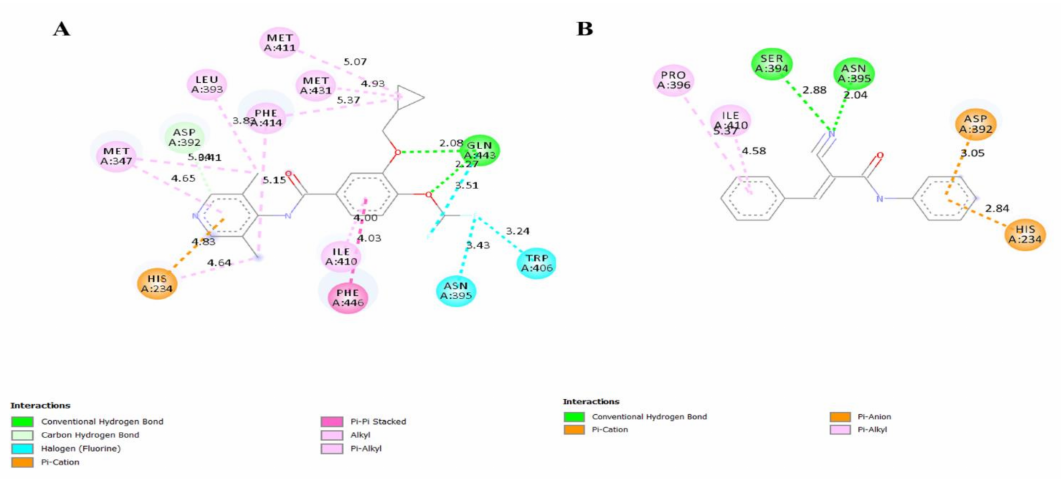
Figure 8. Ligand Roflumilast ( A ) and JMPR-01 ( B ) in PDE4B target (PDB ID: 1XMU). The influence of COX-2 in anti-inflammatory therapy is suggested, which highlights its specific up-regulation at the site of inflammation, mainly in response to the local release of cytokines such as IL-1 and TNF- α , activators of the NF-kB transcription factor [55]. Through the metabolism of arachidonic acid, these generate pro-inflammatory and va- soactive eicosanoids such as prostaglandins (PGD2, PGE2, PGF2 α ), prostacyclins (PGI2), and thromboxanes (TXA2) [56]. Thus, its selective inhibition is an effective way to obtain anti-inflammatory, analgesic, and antipyretic activity without harming the physiological actions inherent to COX-1, a target inhibited by traditional NSAIDs [57]. The selective inhibitor Celecoxib, (IC 50 = 0.132 ± 0.005 µ M against COX-2), establishes